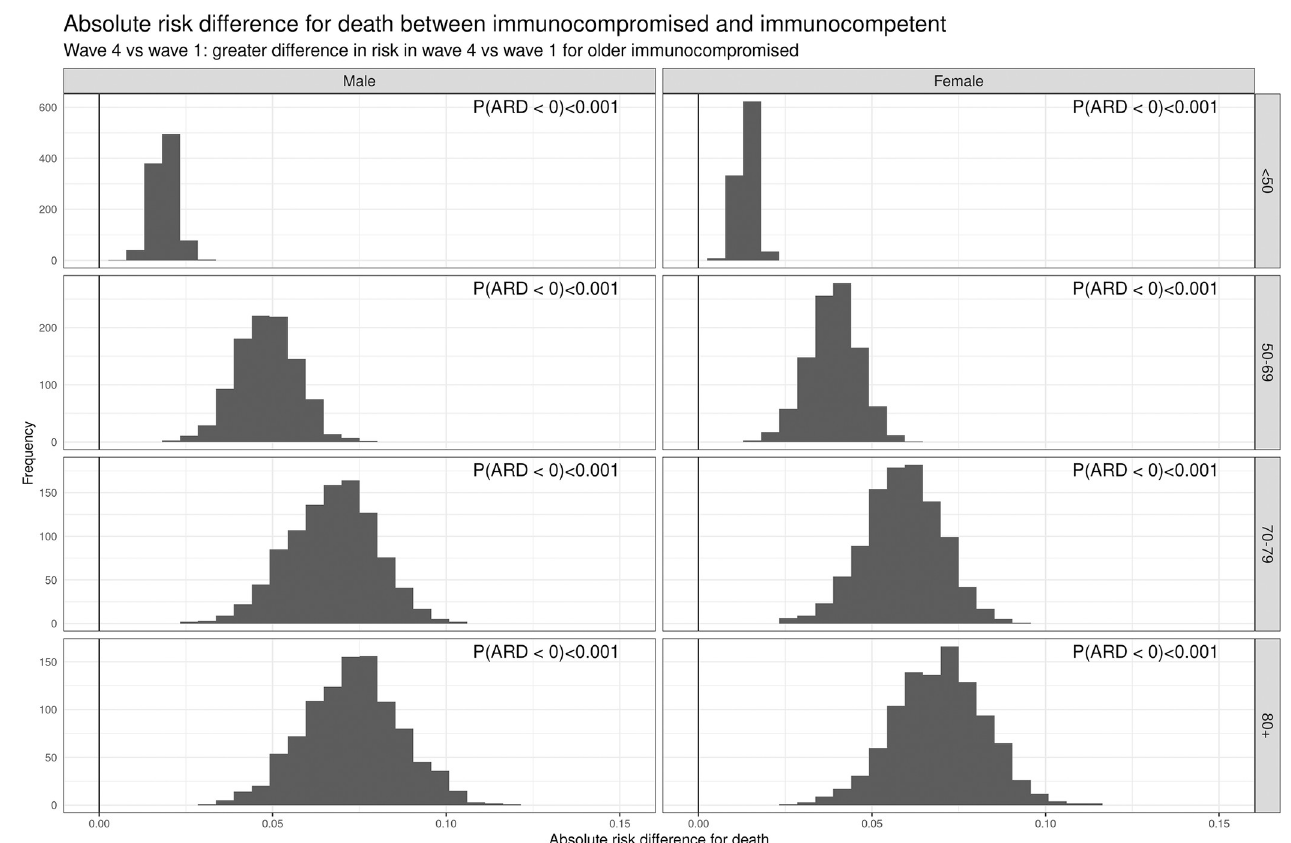
Fig 5. Absolute risk difference (ARD) for death between immunocompromised and immunocompetent. The difference in risk of death in the first wave and the fourth wave for immunocompetent and immunocompromised patients was modelled using Bayesian logistic regression, and the probability that the risk of death across the two waves reduced more in the immunocompetent that the immunocompromised was calculated. The analysis was stratified by age and sex.